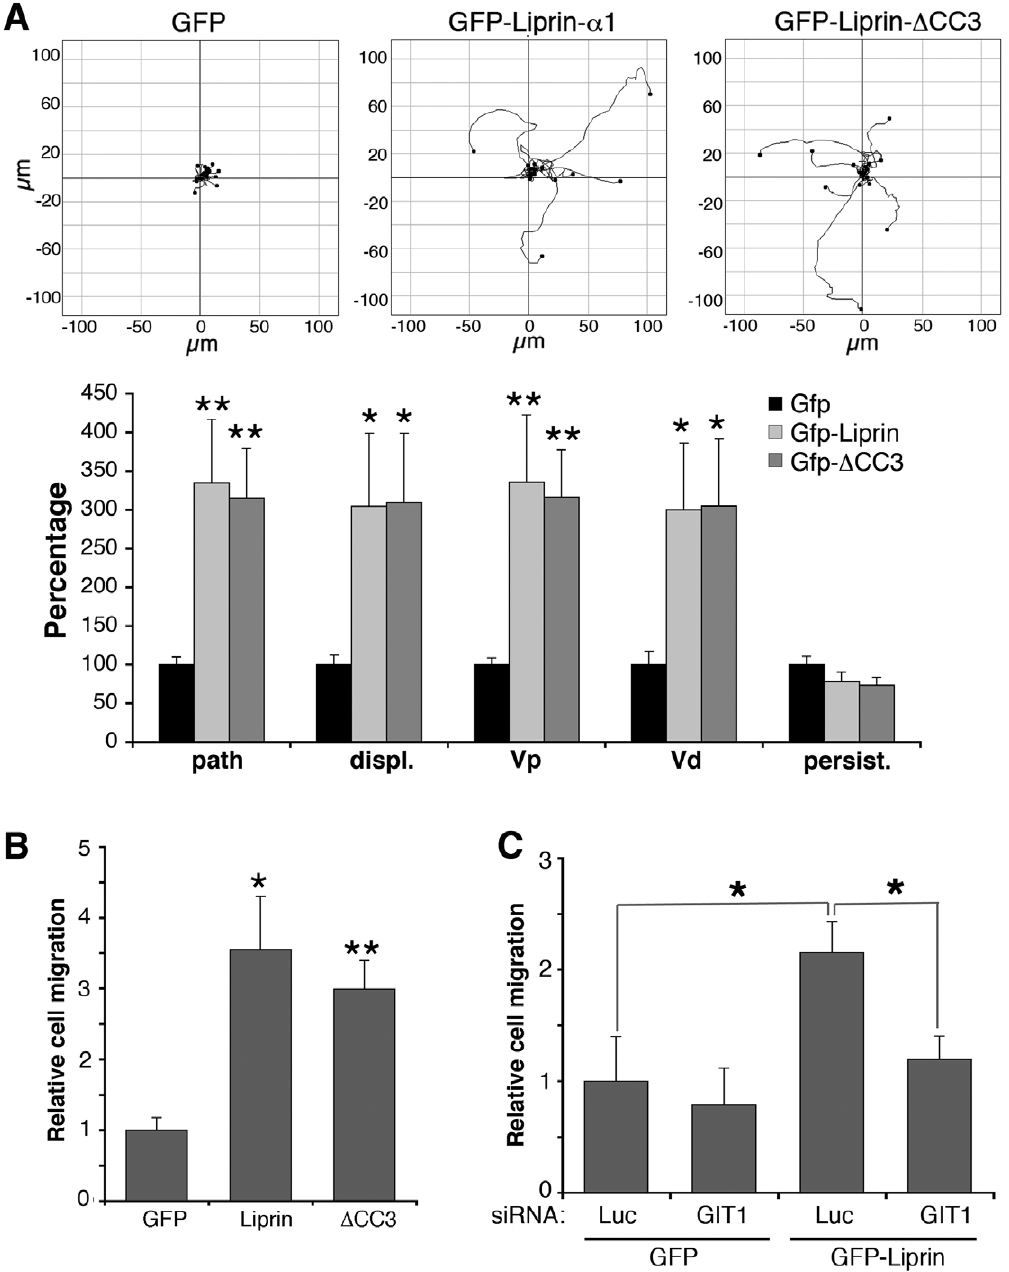
Figure 5. GIT1 is required for liprin- a 1-enhanced COS7 cell migration. (A) Transfected cells were replated on 10 m g/ml FN for 50 min to allow spreading, and then monitored for motility for 2.5 h by taking one frame every 5 min. The upper panels show cell tracks from cells transfected with the indicated constructs. The lower panel shows the quantification (mean values 6 SEM) of different parameters of random migration including cell tracks (path), Euclidean distance (displ.), path rate (Vp), Euclidean rate (Vd) and persistence of migration (persist=path/displ.). N=18–20 cells per experimental condition; *P , 0.05. (B) Transwell migration assays with cells transfected with GFP, GFP-liprin- a 1, or GFP-liprin- D CC3. Bars are normalized means 6 SEM (n=4); *P , 0.05; **P , 0.01. (C) Transwell migration assays with cells cotransfected with the indicated combinations of siRNAs and plasmids. Bars are normalized means 6 SEM (n=4); *P , 0.05.